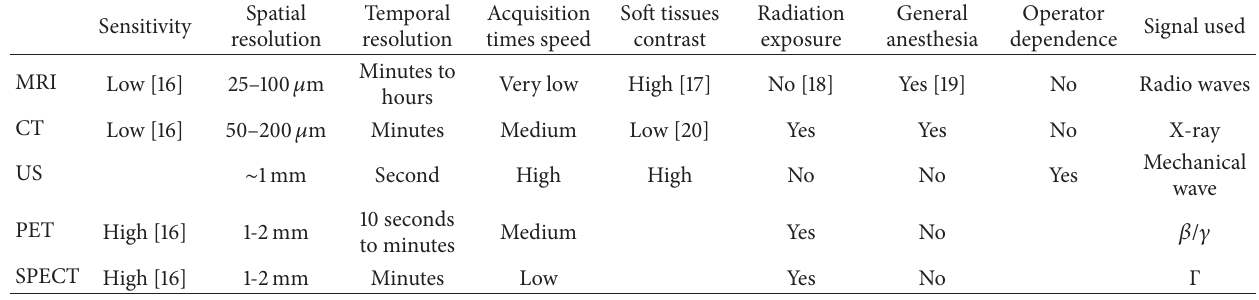
Table 2: Comparing the performances of different imaging modalities.